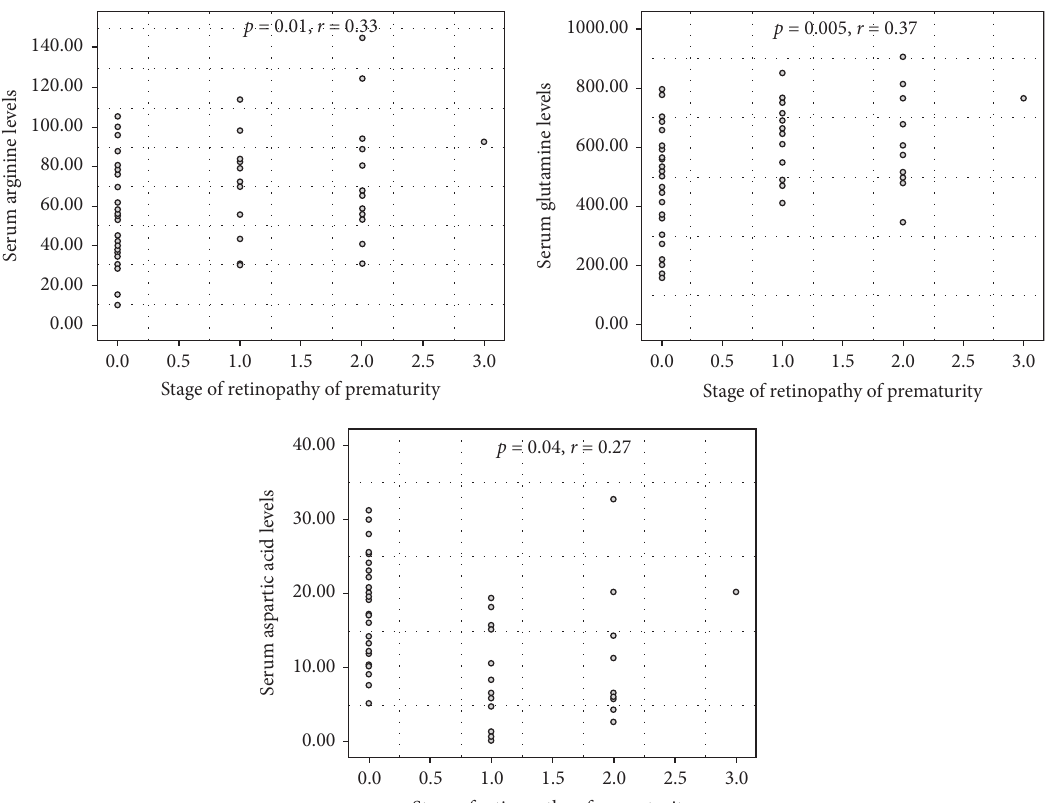
Figure 1: The scatter plots indicate a significant correlation between the stage of ROP and serum arginine, glutamine, and aspartic acid